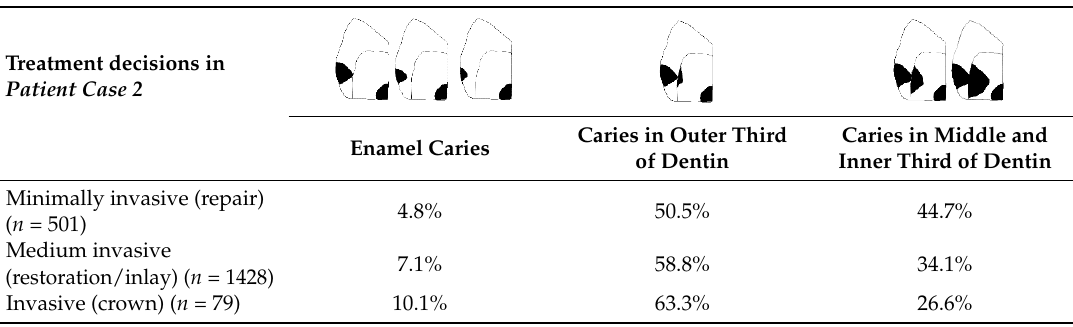
Table 6. Cross tabulation of the decision on how to treat Patient Case 2 and threshold for operative treatment of approximal primary caries. Most dentists choosing minimally invasive treatment in Patient Case 2 only treated advanced stages of approximal caries operatively.